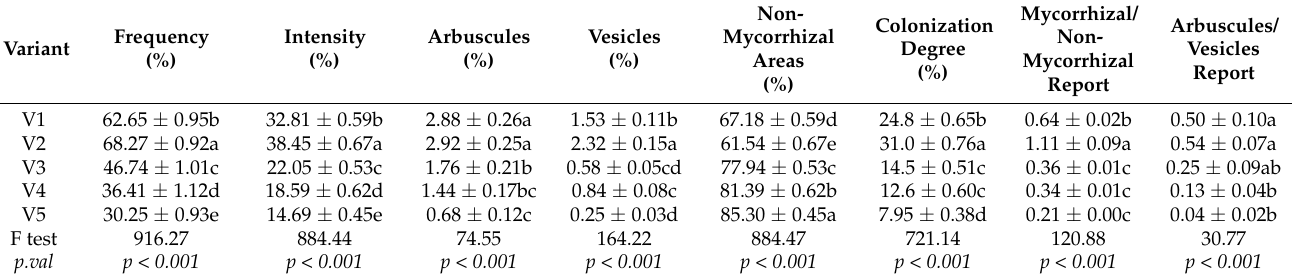
Table 1. Differences induced by treatments in mycorrhizal colonization